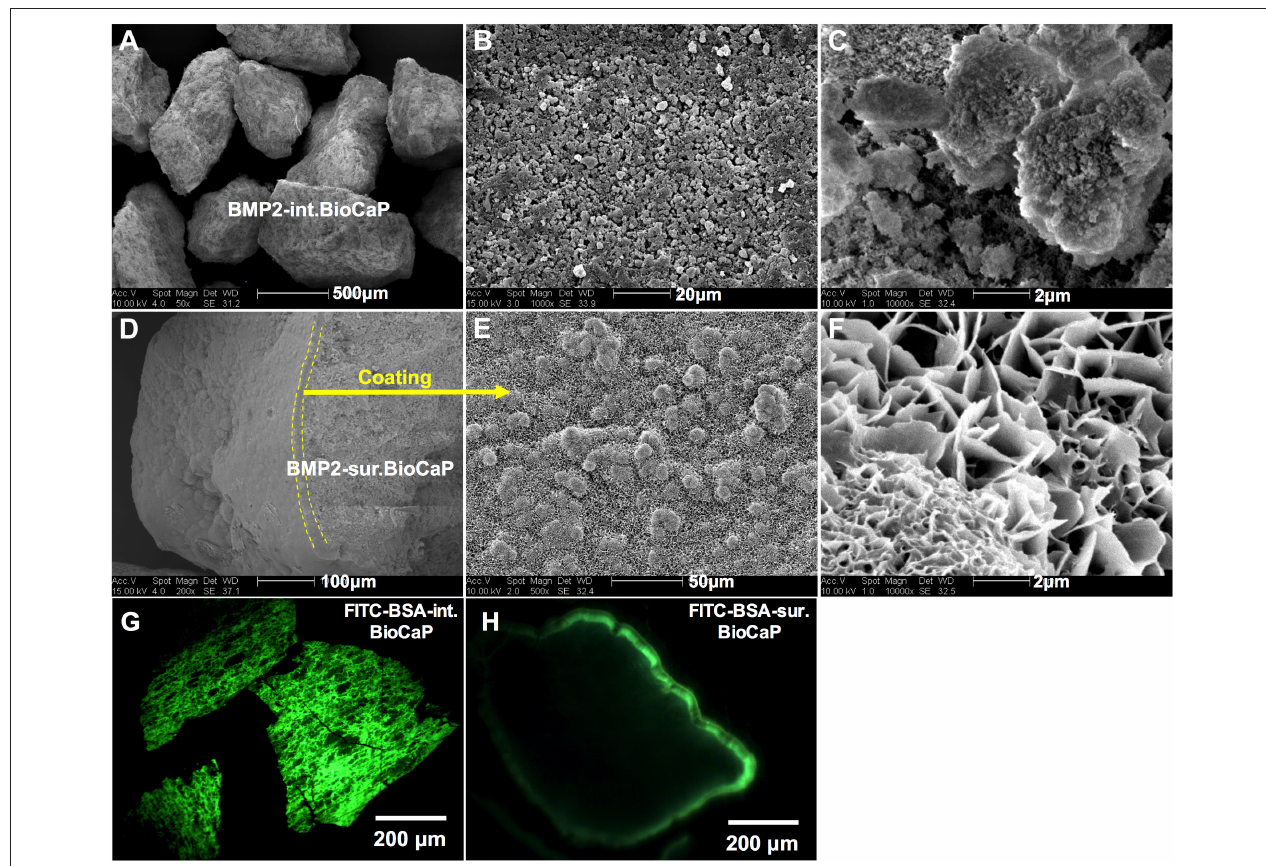
FIGURE 2 | Surface characteristic and morphology of BMP2.BioCaP grafts. Representative SEM images of BMP2-int.BioCaP (A–C) and BMP2-sur.BioCaP (D–F) from lower to higher magnification. Representative fluorescence images of FITC-BSA-int.BioCaP (G) , and FITC-BSA-sur.BioCaP (H) , showing the protein loading and distribution